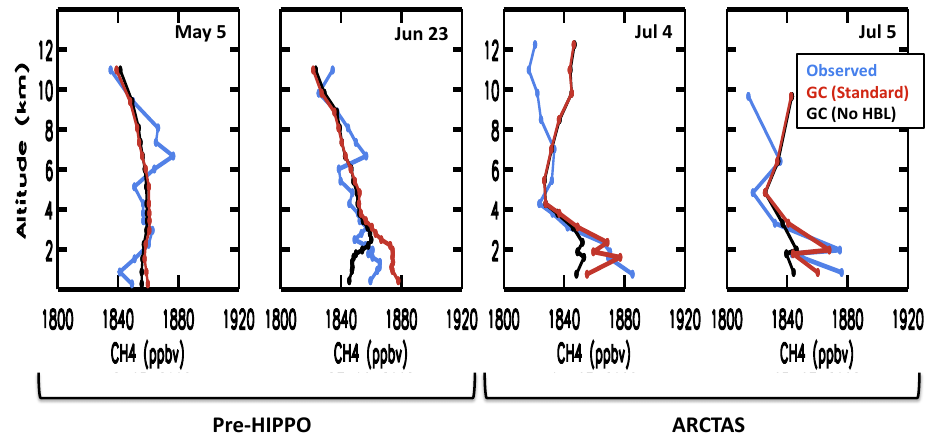
Fig. 2. Methane vertical profiles from Pre-HIPPO and ARCTAS over the HBL (May–July 2008). Observations (blue) are compared to GEOS-Chem (GC) model vertical profiles sampled along the flight tracks at the flight times. The standard simulation (red) and a sensitivity simulation with no HBL emissions (black) are presented.